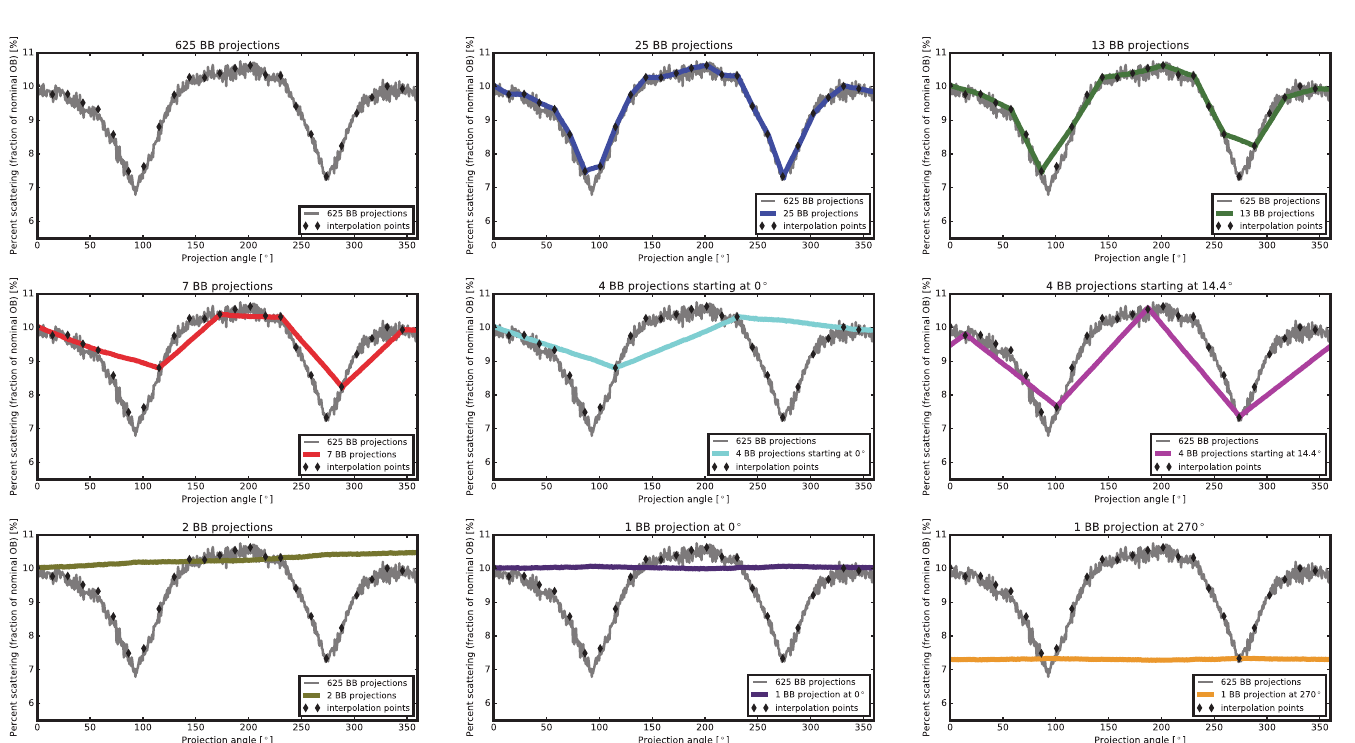
Fig 10. Effect of the interpolation of missing angles on the computed scattering